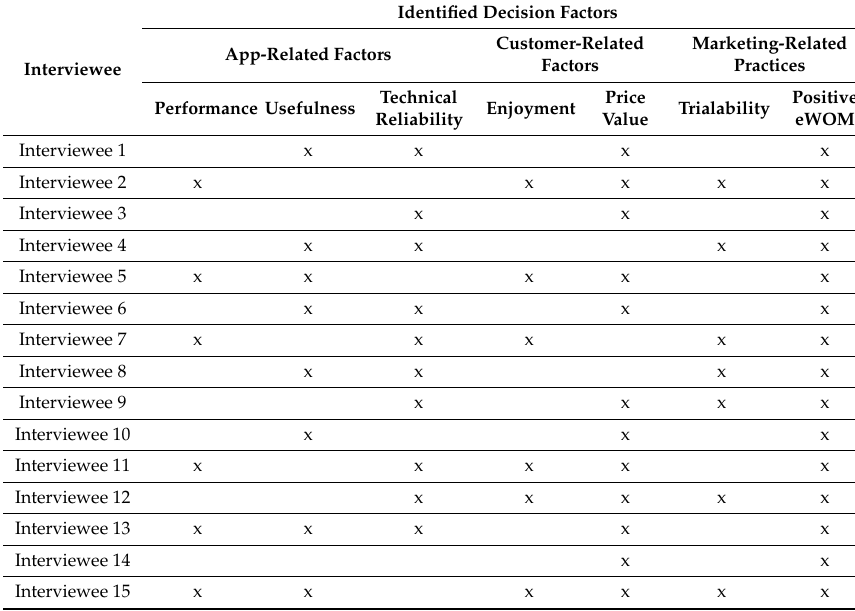
Table 2. Identified decision factors.